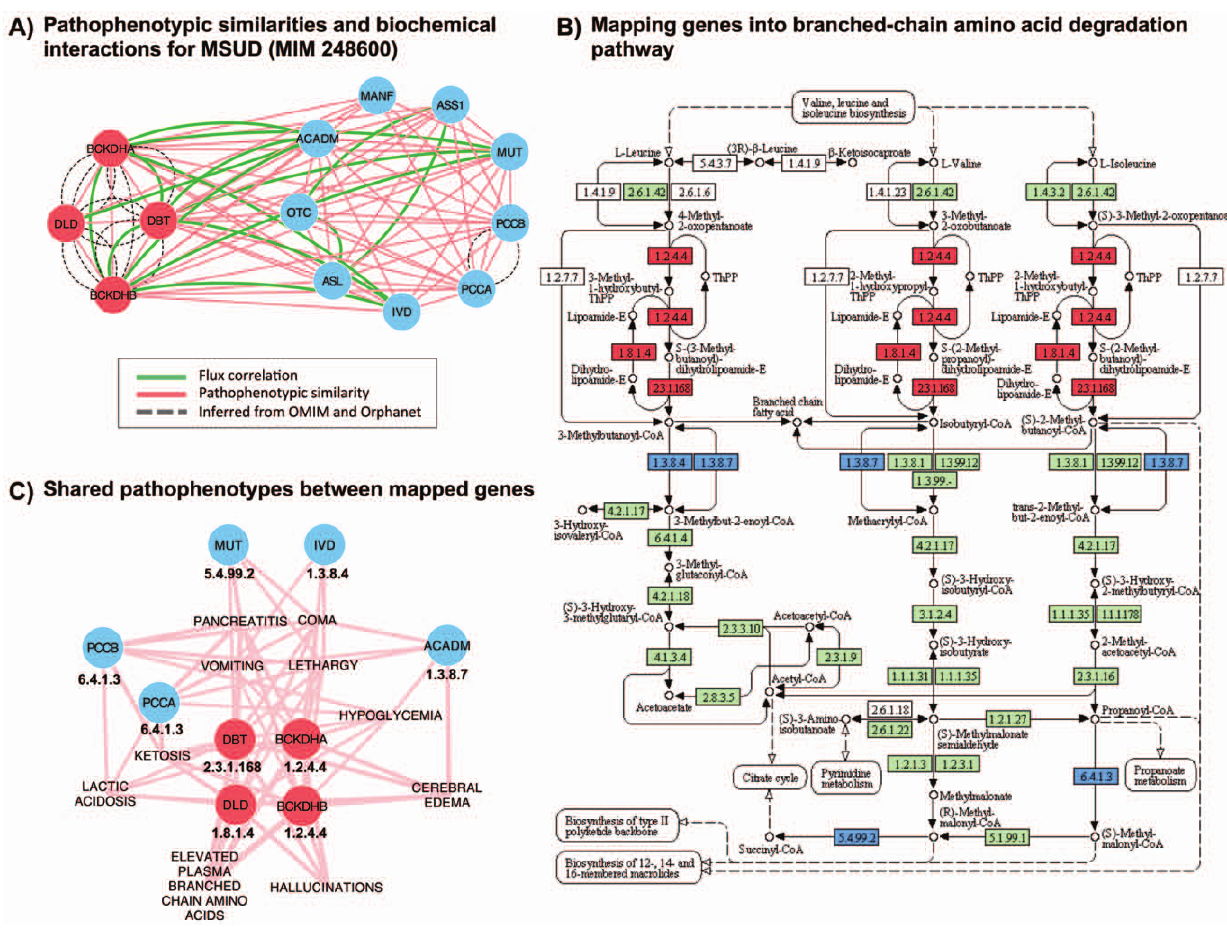
Figure 8. Maple syrup urine disease pathological and metabolic interactions. In red genes associated with MSUD and in blue pathophenotypic similar genes. (A) Pathophenotypic similarity gene sub-network for MSUD causing genes. It can be noteworthy that there are no inferred relationships between MSUD genes and the rest. (B) Map of branched-chain amino acid degradation pathway from. This map has been extracted from the Kyoto Encyclopedia of Genes and Genomes (KEGG, hsa:00280) developed by Kanehisa Laboratories. Enzymes encoded by human genes are in green. (C) Pathophenotypes shared between genes in the same metabolic module.